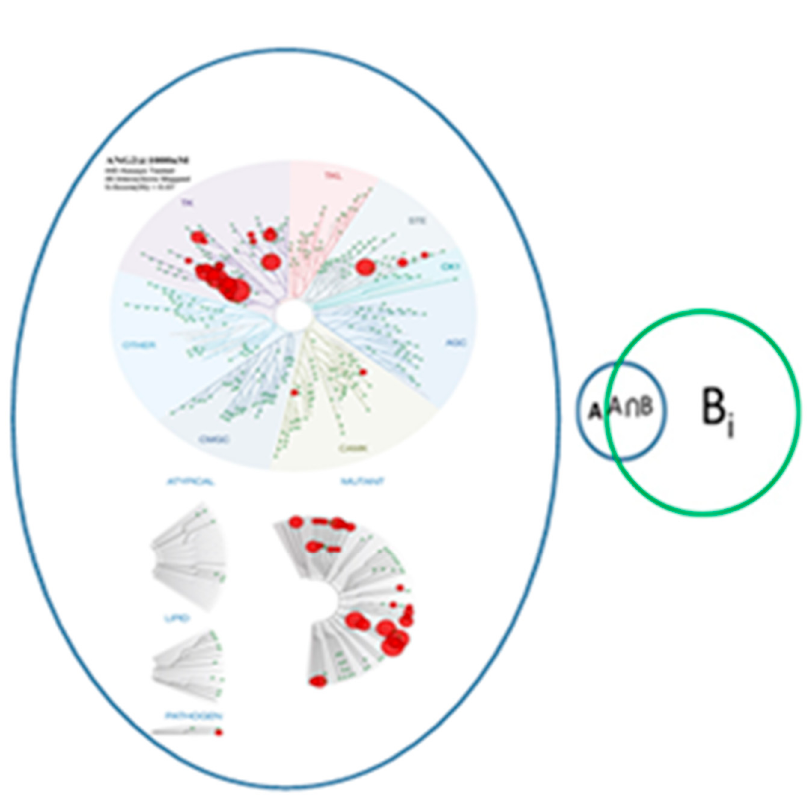
Figure 1. Precision medicine in kidney disease. The signalosome of ANG3070, an orally bioavailable small molecule fibrokinase inhibitor is depicted within the blue circle. The red hotspots indicate signaling elements modulated by this drug candidate. A precision medicine approach is being used to inform inclusion criteria for an ANG 3070 clinical trial in nephrotic syndrome- focal segmental glomerulosclerosis (NS-FSGS). Renal biopsy and urinalysis from these patients will be subjected to omics analysis and signalosomes (green circle) identified for each patient. Only those patients will be recruited that share 70% of the ANG3070 signaling elements.